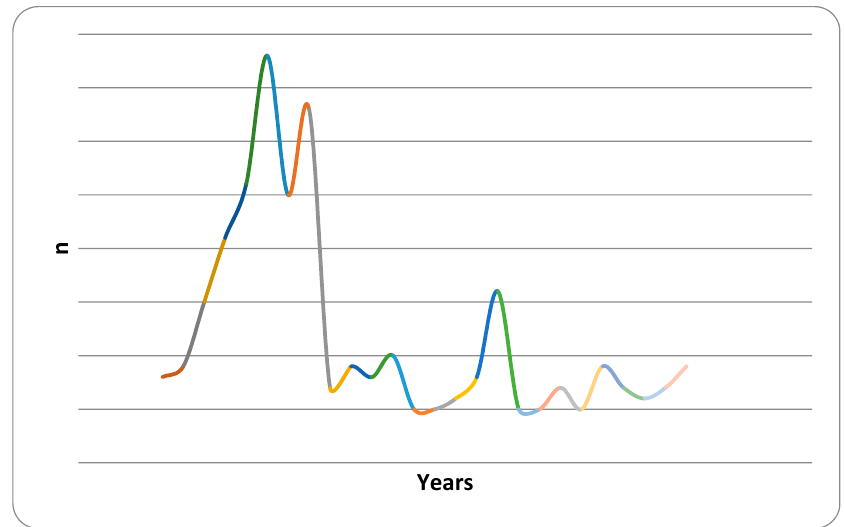
Figure 2. Dispersion of respondents by the work experience.